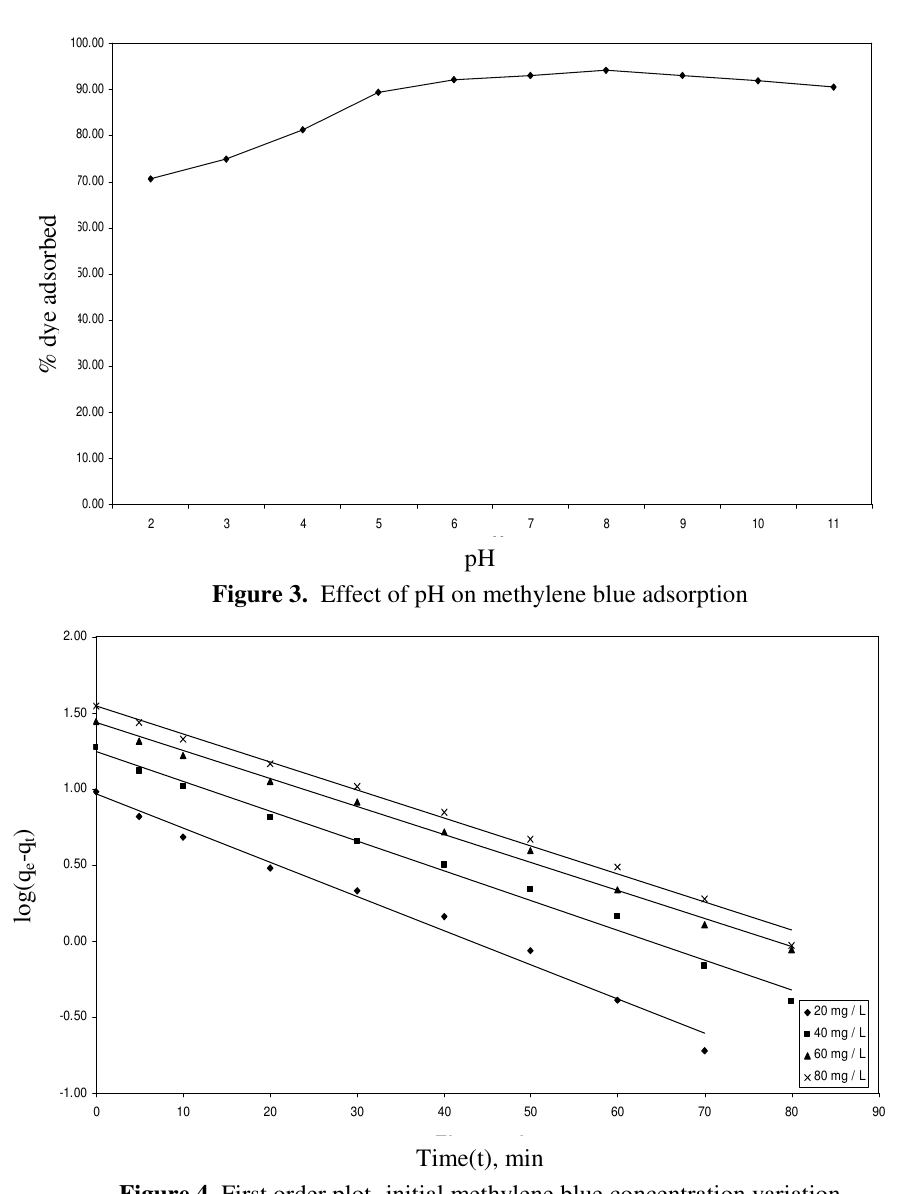
Figure 4. First order plot -initial methylene blue concentration